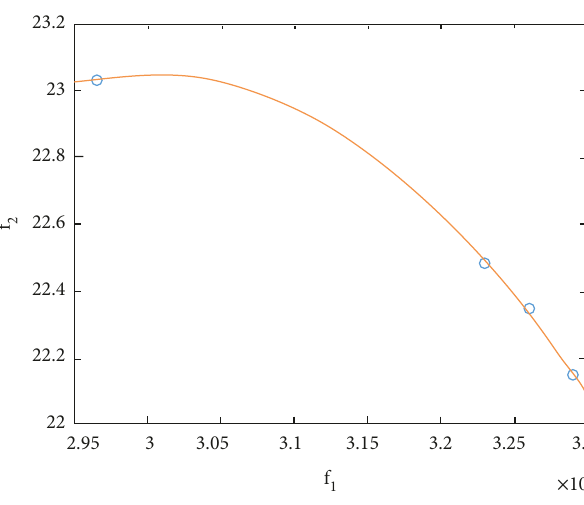
Figure 9: Pareto solution